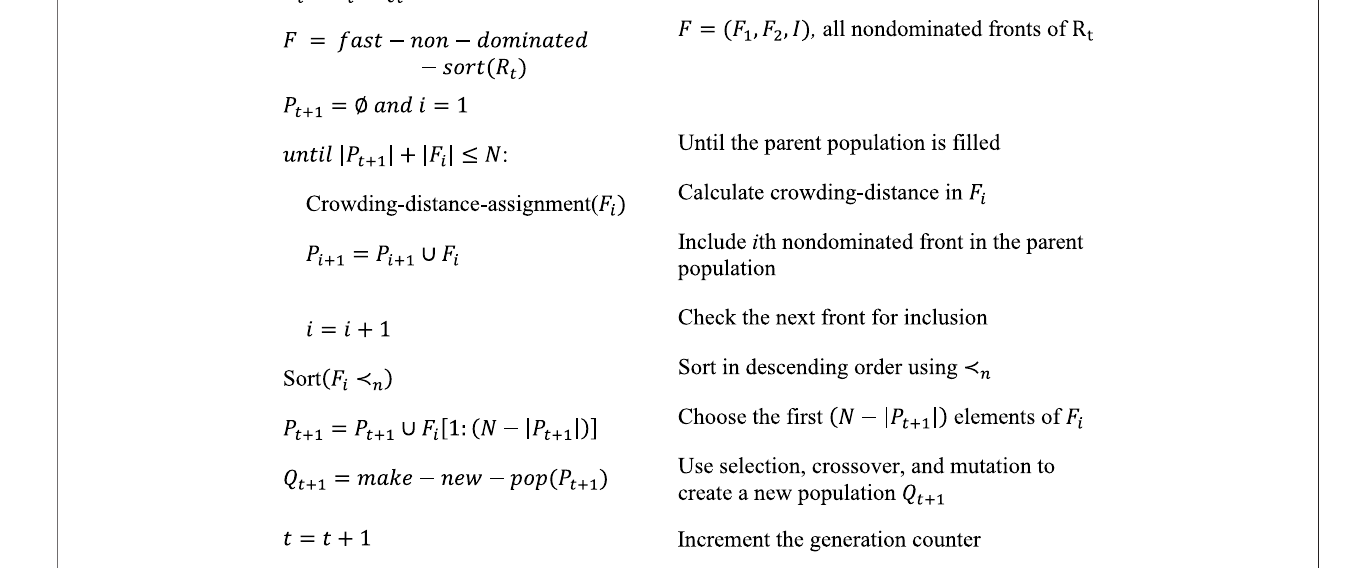
Frontiers in Energy Research |